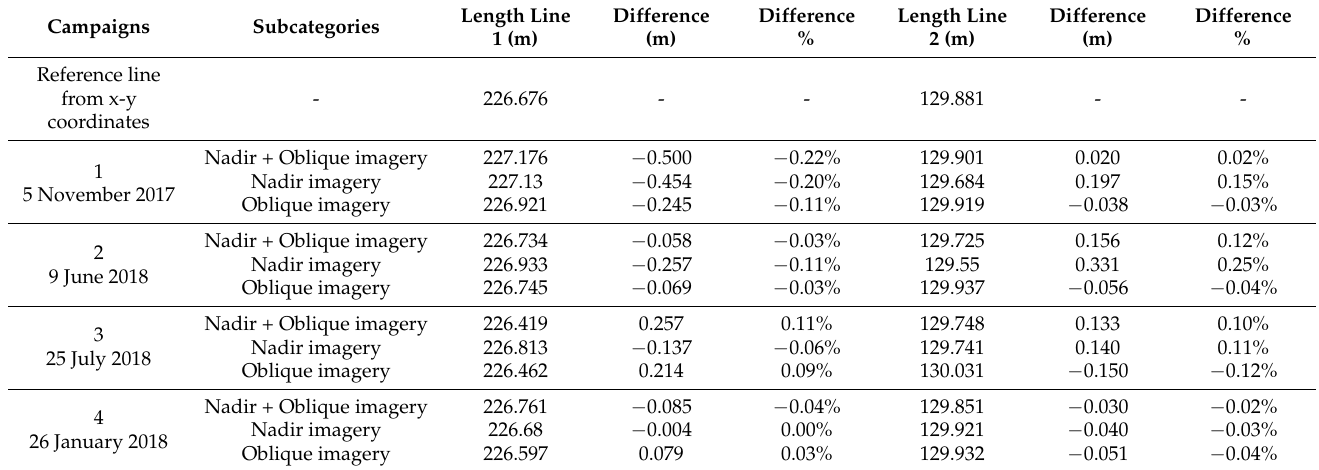
Figure 7. The distribution of the permanent pillars and the geodetic lines throughout the study area. Table 5. Length of the geodetic lines in accordance with the reference length.